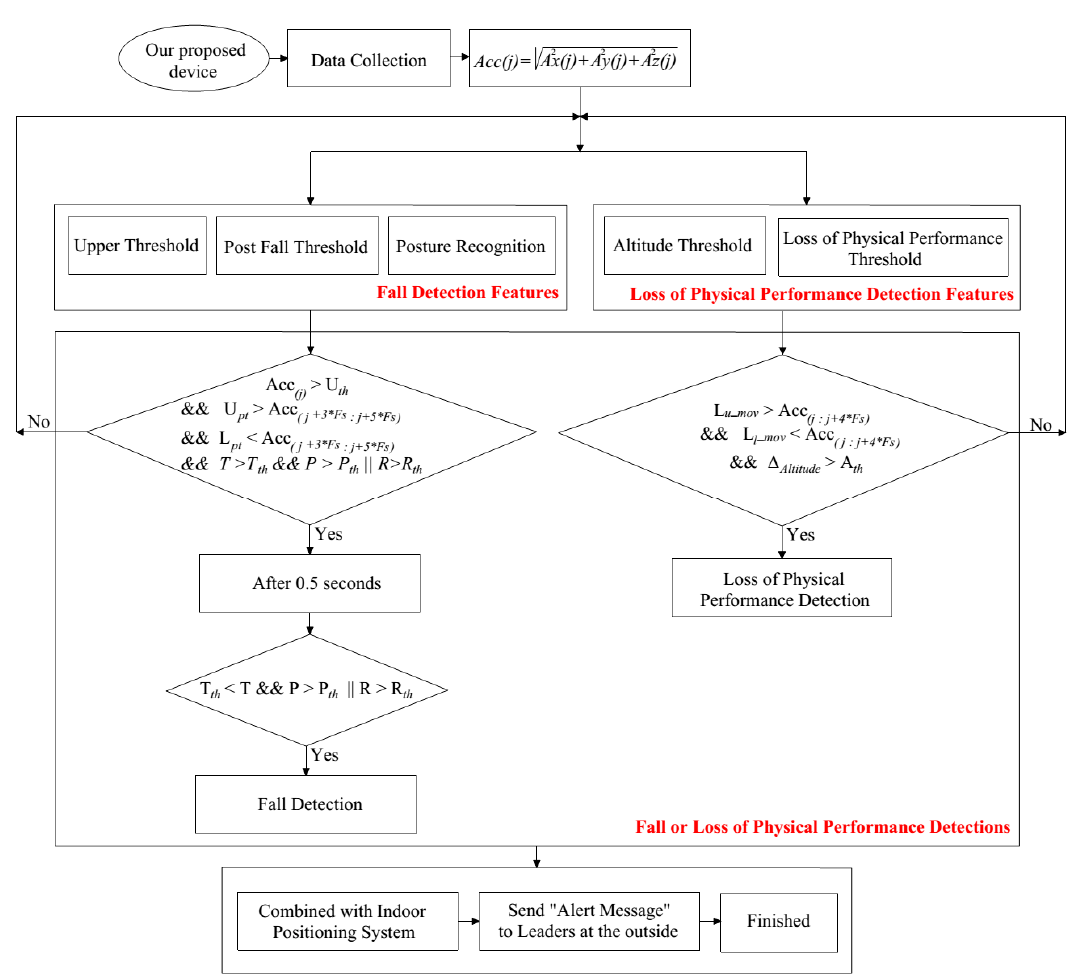
Figure 5. The flowchart for fall detection and loss of physical performance detection for firefighters.